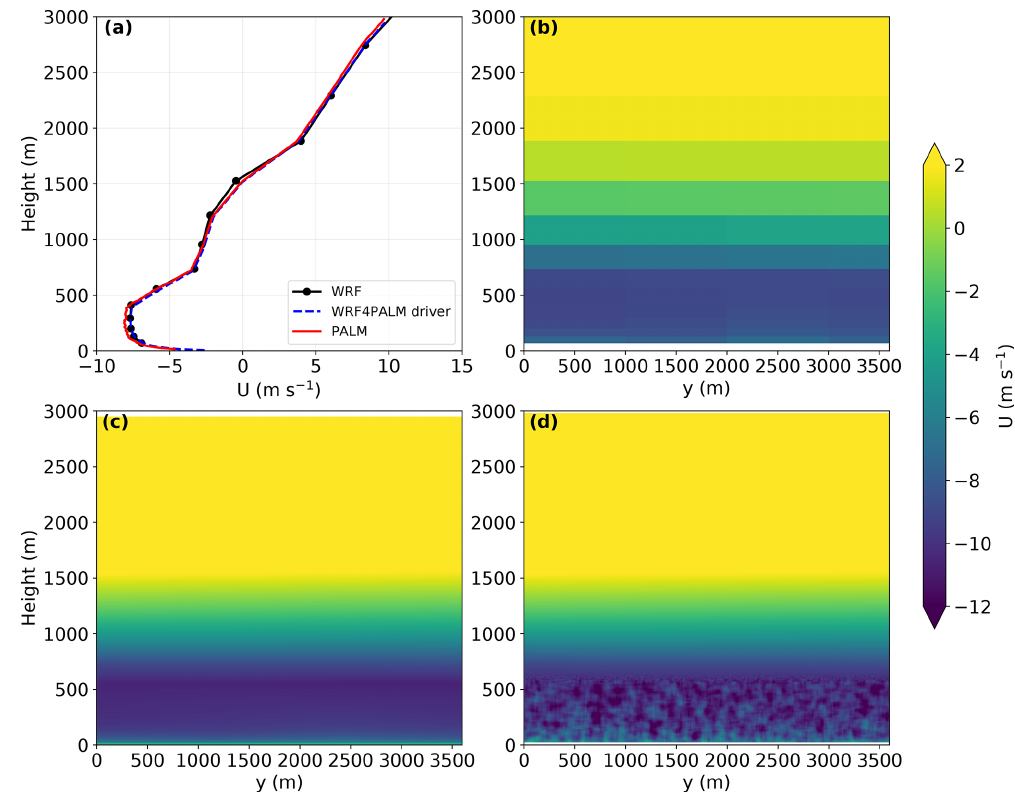
Figure 11. As in Fig. 5, but for the north-easterly case. Panels (b) , (c) , and (d) are at 16:00NZDT, 16 May 2017.